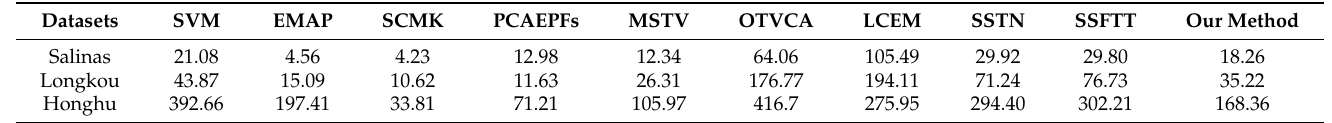
Figure 10. Classification effects of different classification approaches on the Salinas dataset with different amounts of training samples per class (varying from 5 to 50 with step 5). ( a ) Overall accuracy (OA). ( b ) Average accuracy (AA). ( c ) Kappa coefficient. The widths of the line areas indicate the standard deviations of accuracies obtained in ten repeated experiments. Table 5. Computing times of different classification approaches on three hyperspectral datasets (in